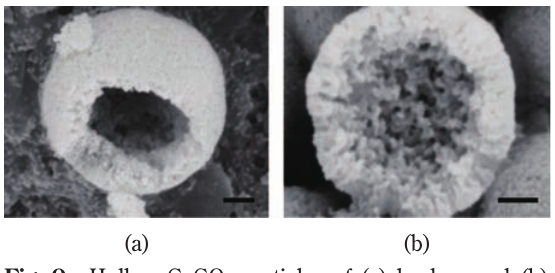
Fig. 9 Hollow CaCO 3 particles of (a) broken and (b) cross-section areas which were prepared by bubble template method. Scale bars are 1 μ